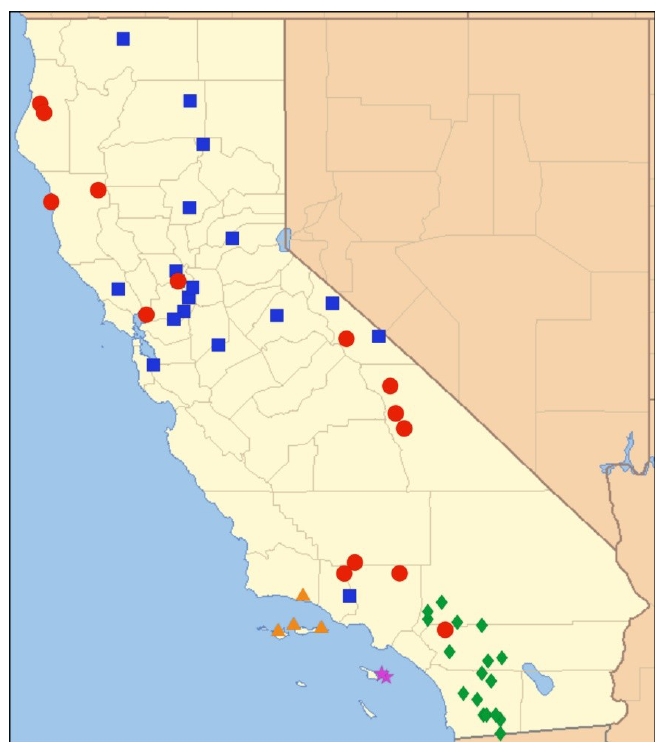
Figure 63. Distribution of Okanagana arboraria (blue squares), O. hirsuta (orange triangles), O. wymorei (red circles), O. catalina (purple stars) and O. nigriviridis (green